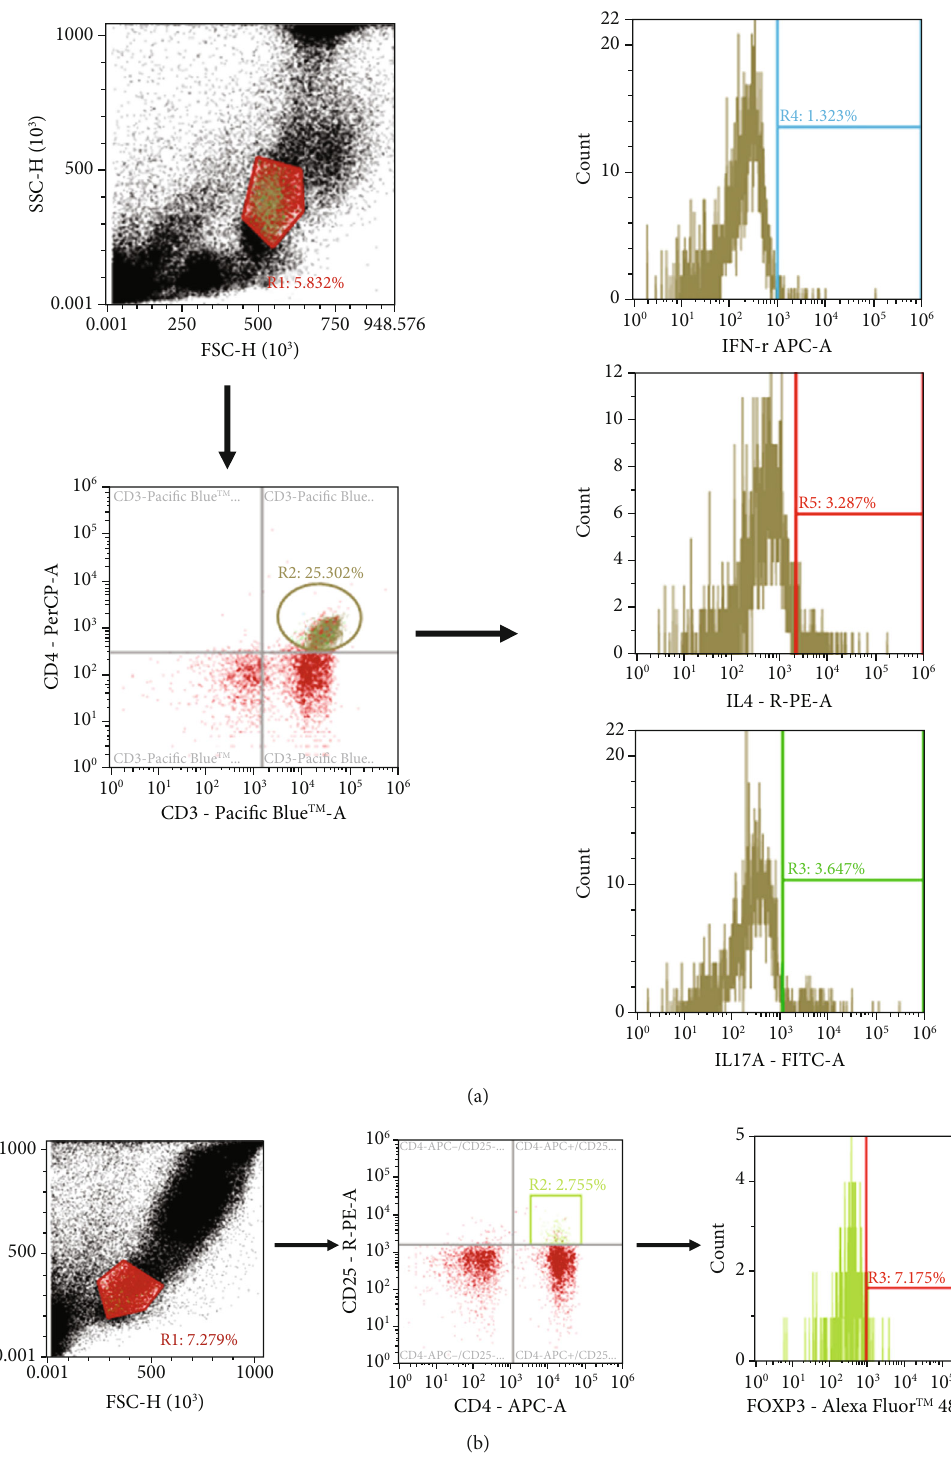
Figure 2: Representative fl ow cytometry data to illustrate the gating strategy for lymphocytes in blood. Lymphocytes were fi rst identi fi ed based on low FSC and SSC characteristics. (a) CD4-positive (CD4+) lymphocytes were gated to analyze the percentages of IFN- γ -, IL-4-, and IL-17-expressing CD4+ cells. (b) Treg cells were identi fi ed as Foxp3 + CD25 + in CD4 +